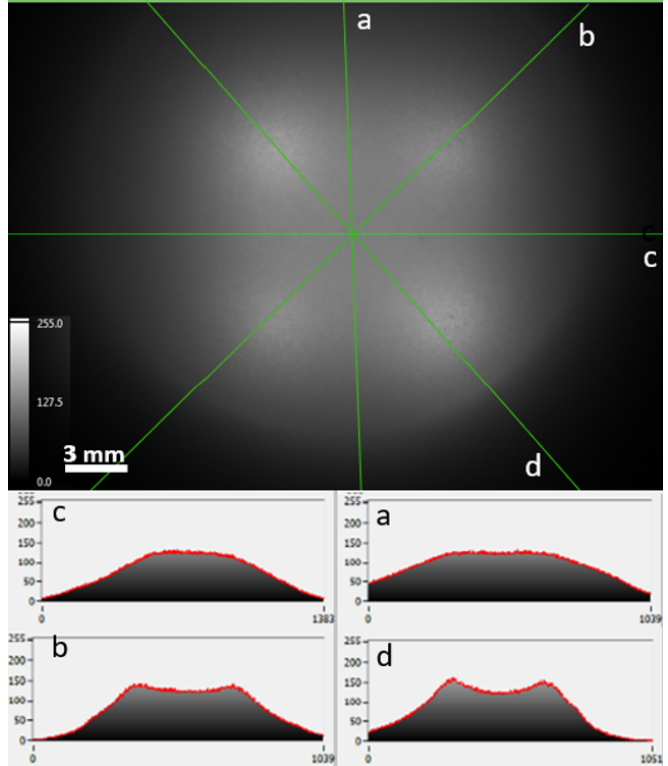
Figure 4. Re-imaged far field from the LED matrix at 1 cm from source with line scans showing the pixel homogeneity level. The peak deviation from uniformity values for 4 indicated line scans in the image are ( a ): 6%, ( b ): 10%, ( c ): 6%, ( d ): 15.6%, respectively.